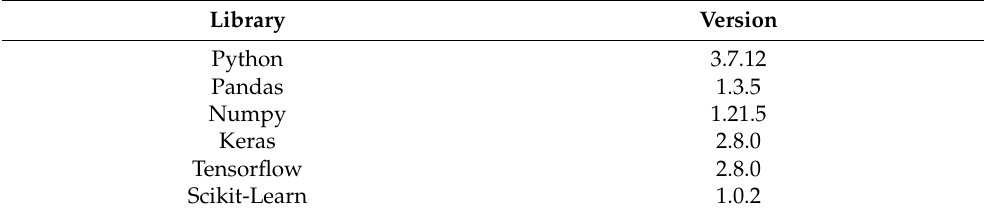
Table 5. Programming